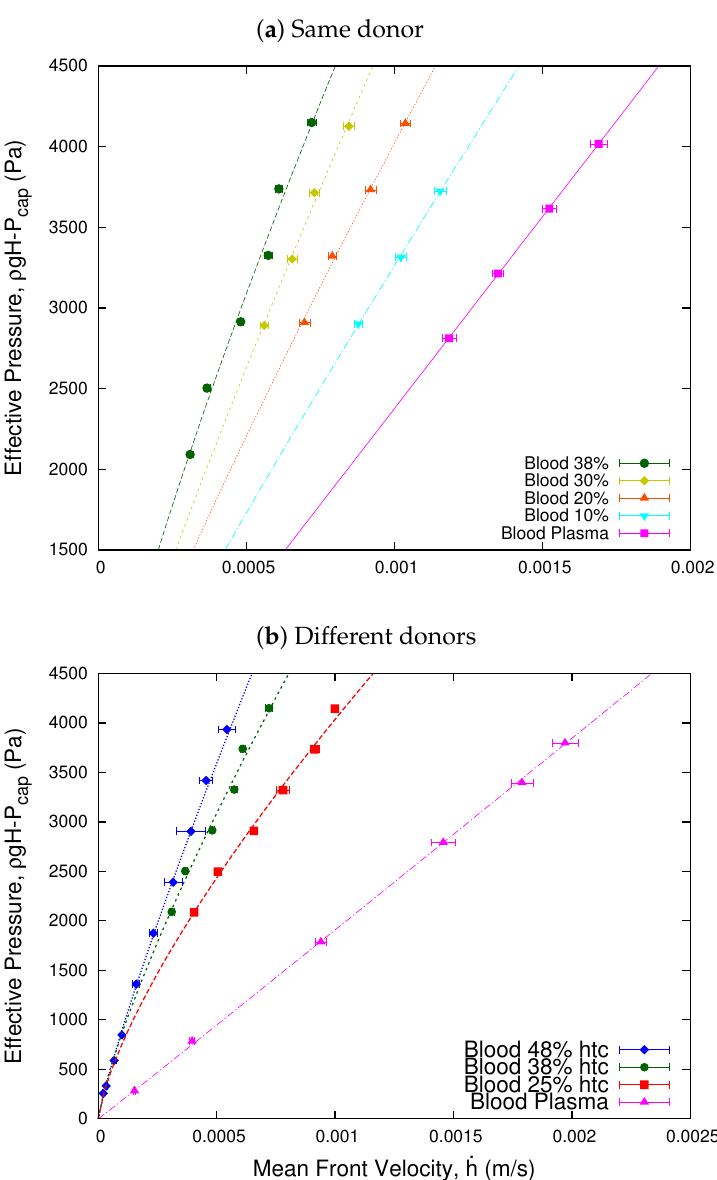
Figure 2. Effective pressure vs. mean front velocity. The figure shows the effective pressure ∆ P = ρ gH − P cap as a function of the velocity of the blood front. Plot ( a ) Same donor shows ef f the viscosity of a single 38% hematocrit blood sample separated in different concentrations of ery- throcytes. For the plasma sample, the value of the exponent is n = 1.001, indicating its Newtonian behavior. The values of the exponents of the samples vary from n = 0.80 to n = 0.91 for the 10% sample, which indicates that the samples decrease their shear thinning behavior for low hematocrit. Plot ( b ) Different donors shows the results for samples extracted from different donors, according to a power law fit. For the plasma sample of the 48% hematocrit, the value of the exponent n = 1.01 indicates its Newtonian behavior. Meanwhile, for the blood samples, the exponents range from n = 0.86 to n = 0.73, indicating that all the samples present a shear thinning behavior. The values of the exponents n for each curve were obtained fitting Equation (12) to the experimental